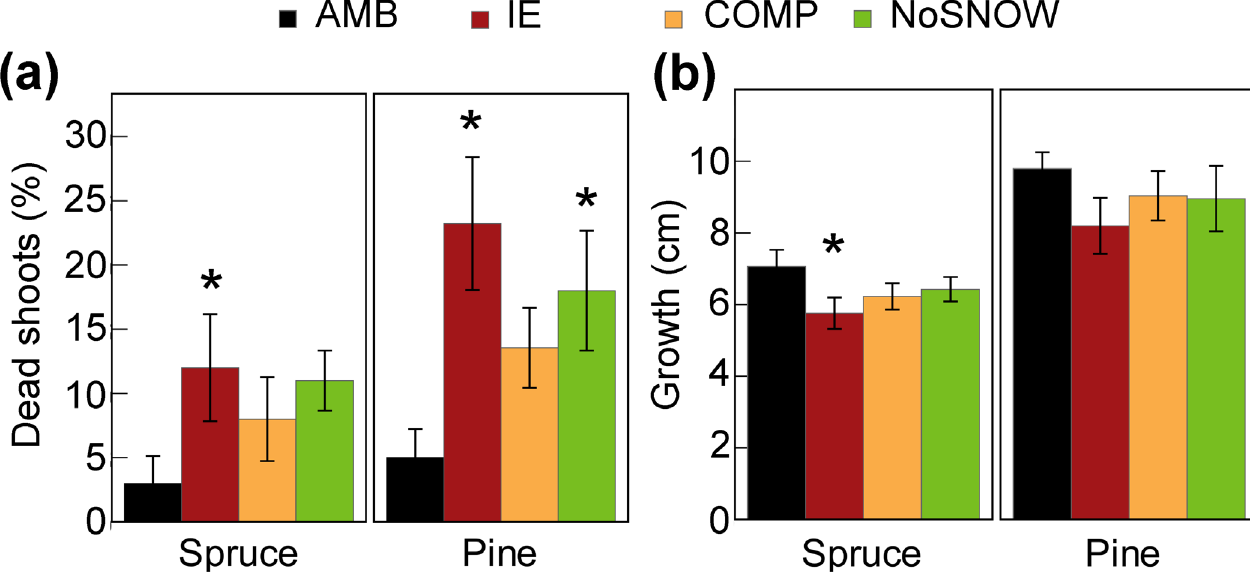
Fig 5. Effect of snow manipulation on main shoot winter survival (a) and shoot growth (b) at the end of the growing season (September 30, 2014). An asterisk indicates statistically significant difference with AMB plots at p < 0.05. Values are means ± SE (n =